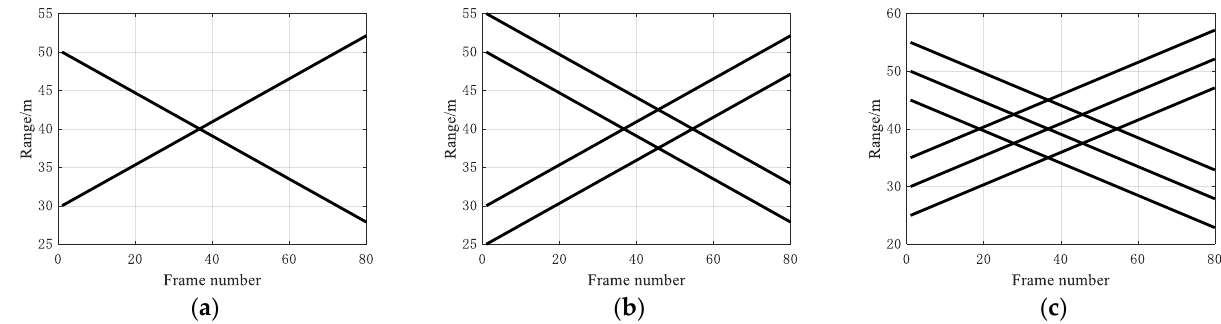
Figure 6. Cross trajectory scenarios with different numbers of targets: ( a ) two targets; ( b ) four targets; ( c ) six targets.